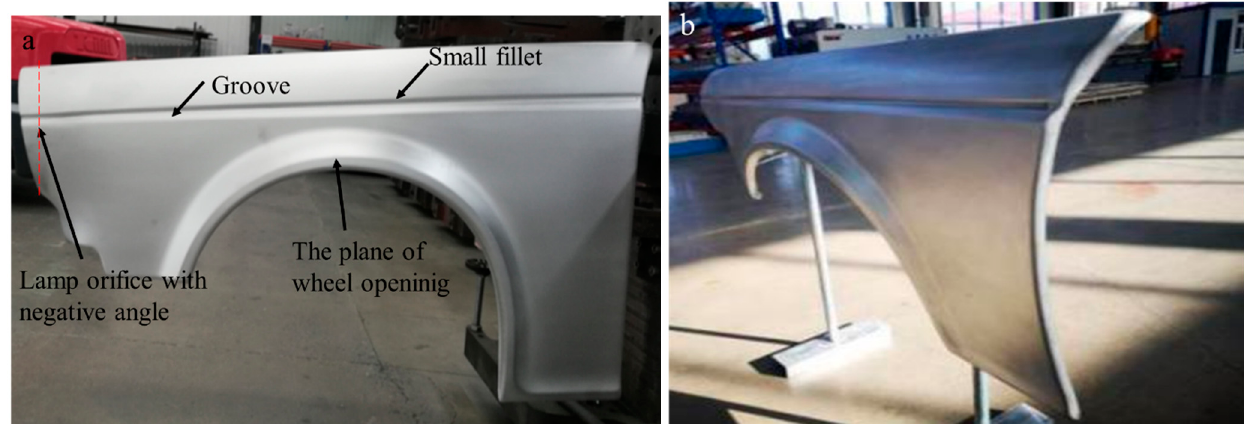
Figure 16. Front automobile fender: ( a ) elevation view; ( b ) side view.